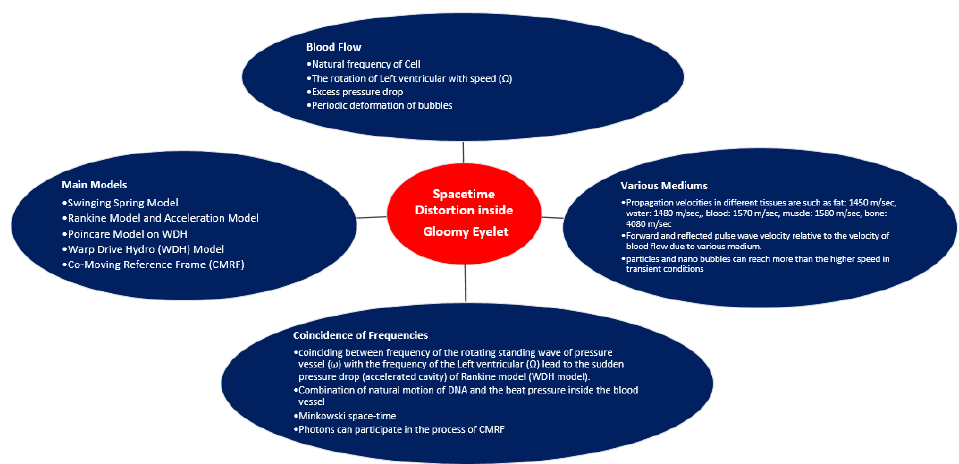
Figure 6. Effective processes and their relationship in the formation of gloomy eyelet inside the cell nucleus .